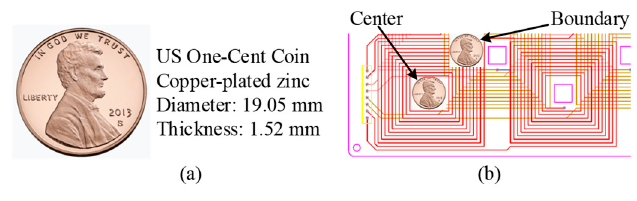
Figure 14. MO. ( a ) Photograph, ( b ) positions.